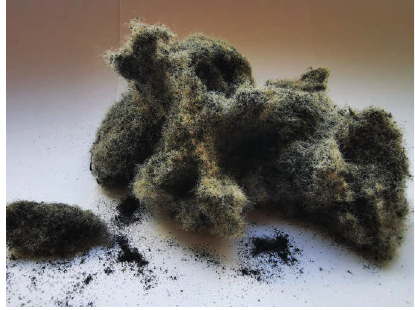
Fig. 1. Waste Tyre Textile